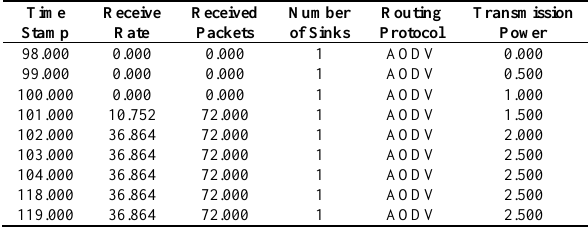
Figure 3. Acquisition of the Mobility